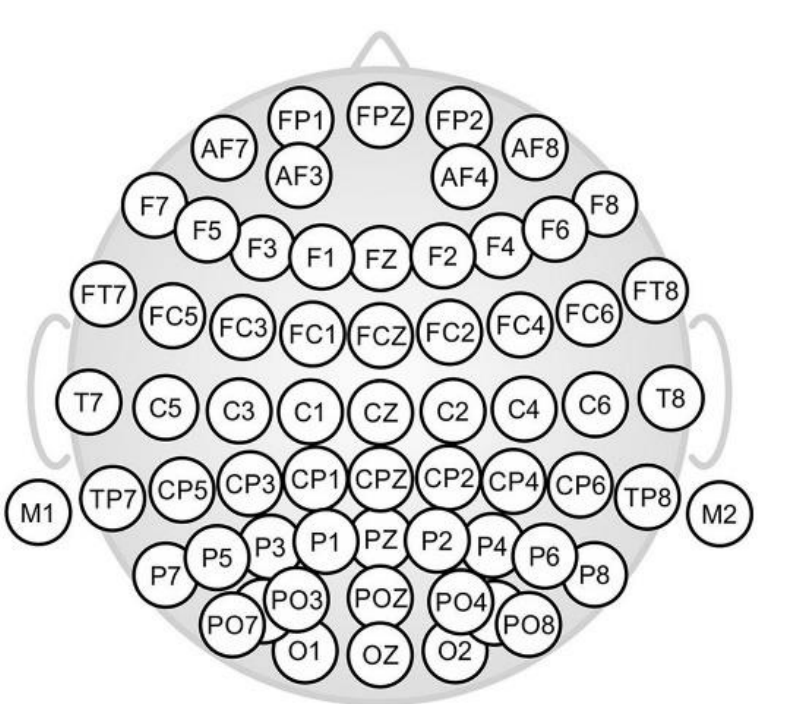
Figure 2. The 64-channel electrode cap topographic layouts with extended 10–20 layout (shows nose on top). Figure retrieved from Di Fronso et al. [22].